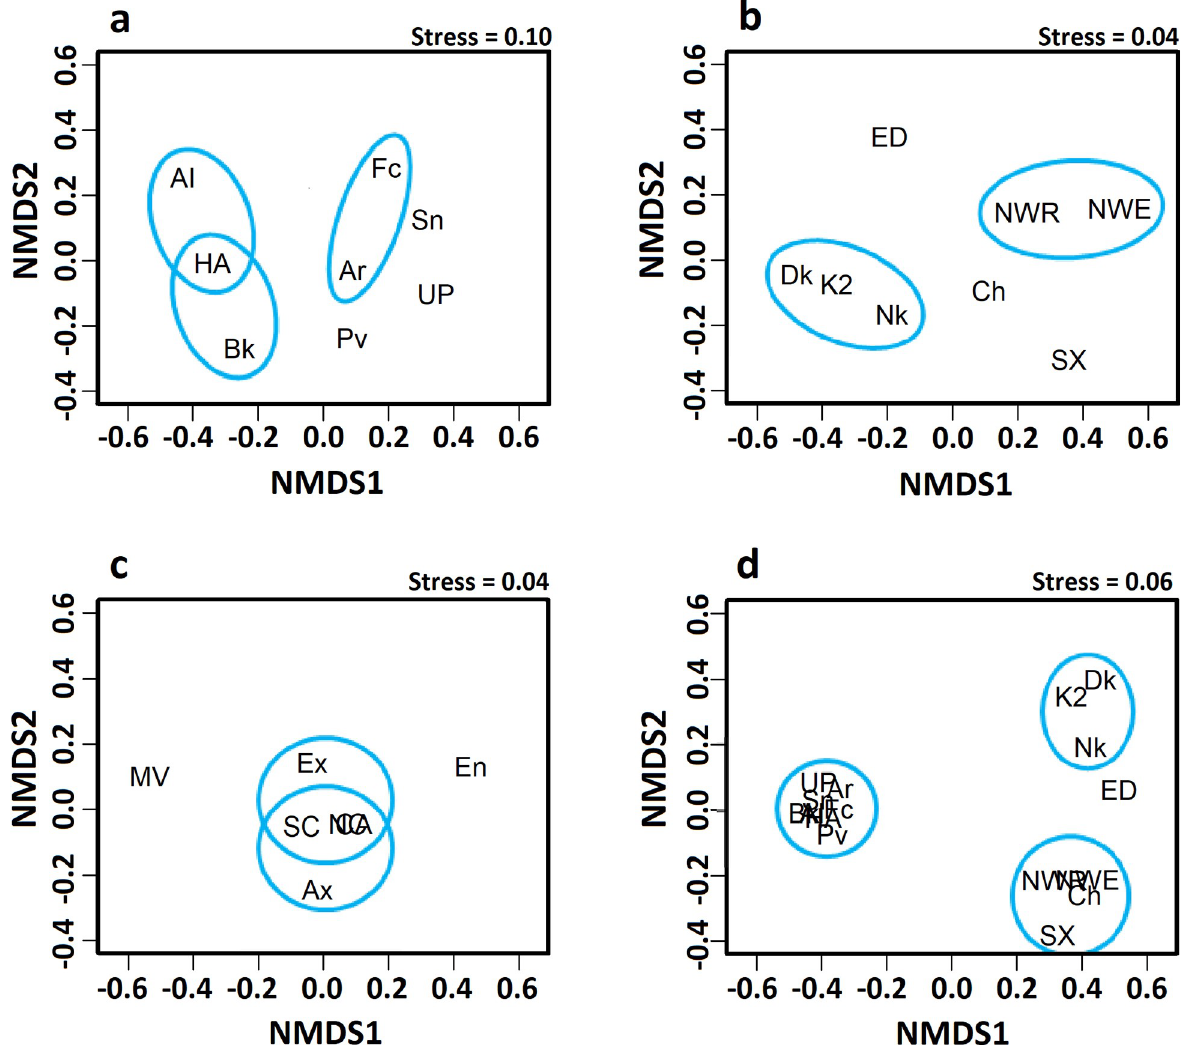
Fig 4. nMDS plots illustrating the β RC -diversity values of hydrothermal vent assemblages in the Mariana back-arc, volcanic arc and Juan de Fuca ridge. Non-metric multidimensional scaling (nMDS) plots illustrating the dissimilarity of vent sites in each system relative to the null expectation of random assembly ( β RC -diversity). Site name abbreviations match those in Table 3. Blue ellipses represent the sites that are significantly more similar to each other ( β RC -diversity). (a) Mariana back-arc ridge system; (b) Mariana volcanic arc system; (c) Juan de Fuca/ Explorer mid-ocean ridge system; (d) Mariana region including the back-arc and volcanic